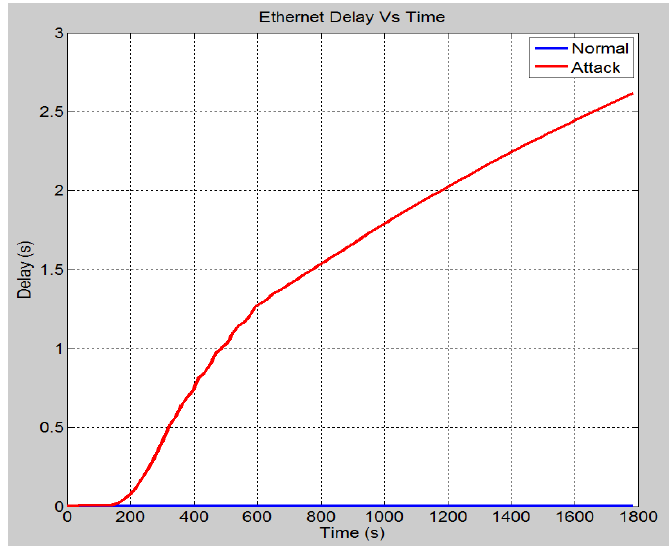
Figure 9. Average global ethernet delay (s).